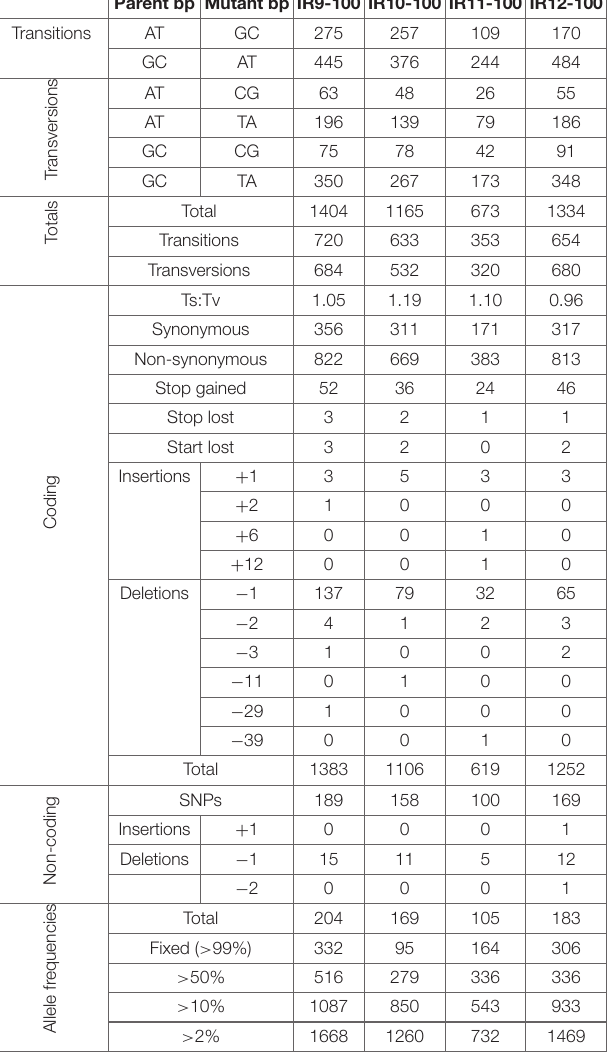
TABLE 1 | Number and types of mutations in evolved populations after 100 cycles of